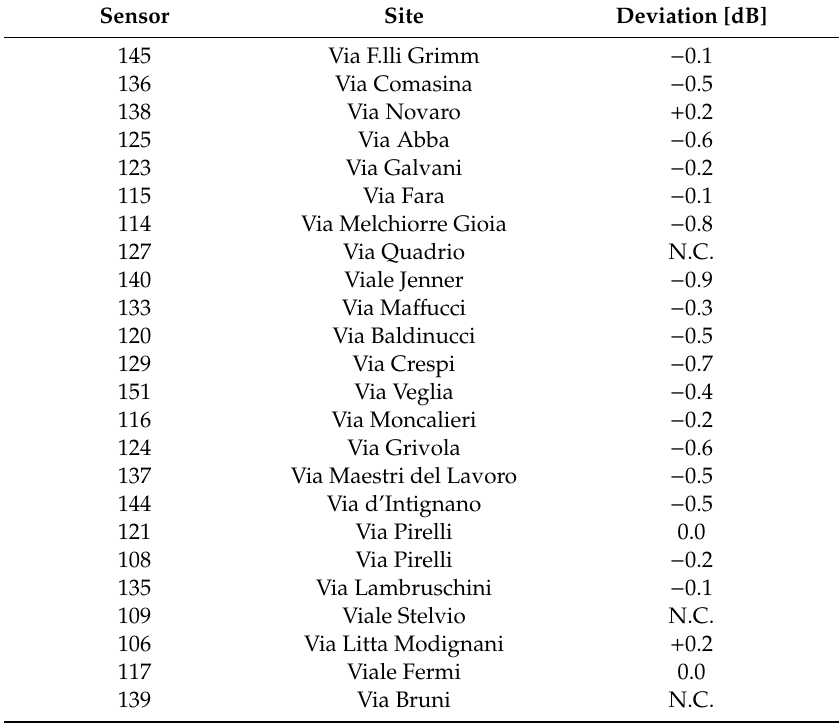
Table 4. Calibration deviations of DYNAMAP sensors (values are in dB; N.C.: Not Calibrated).